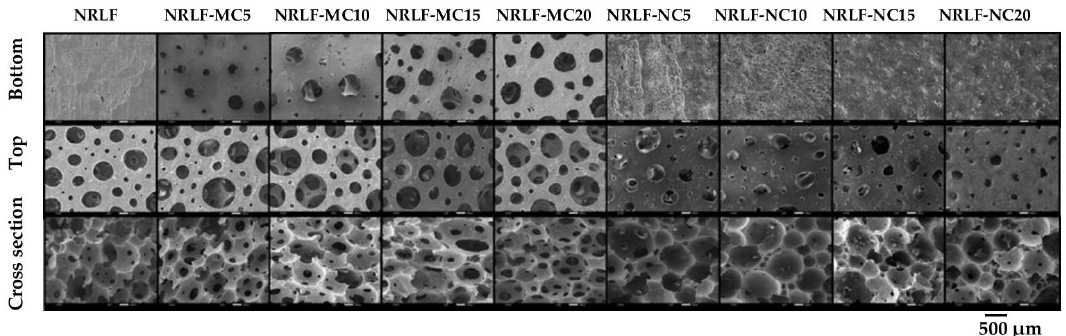
Figure 3. SEM images of surfaces (bottom and top) and cross section views of NRLF composites.